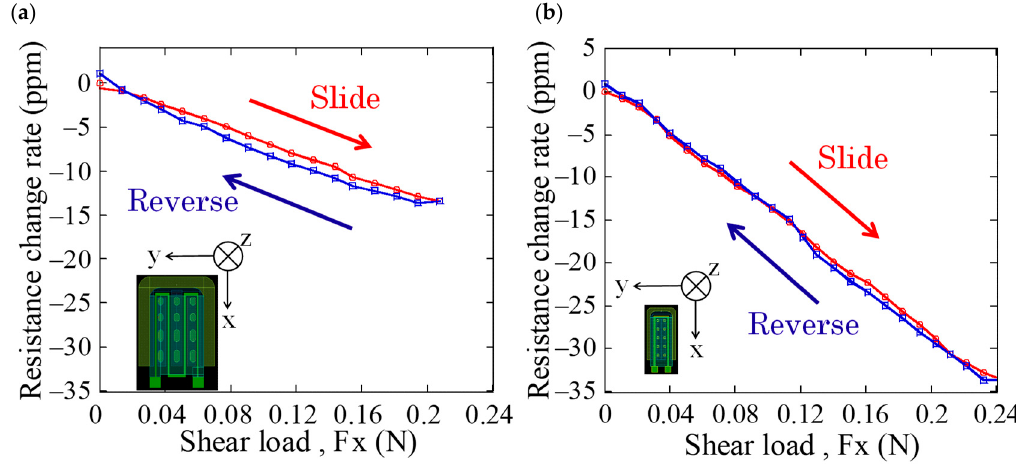
Figure 9. Response characteristic for shear load of ( a ) conventional cantilever, and ( b ) newly fabricated cantilever.